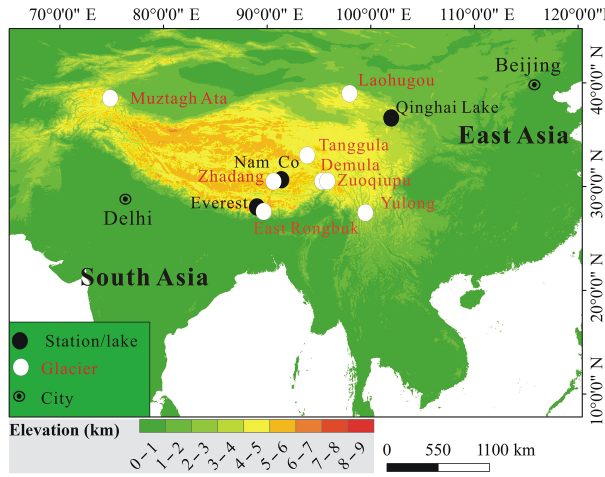
Figure 1. Selected study sites, including the HTP stations, lakes and